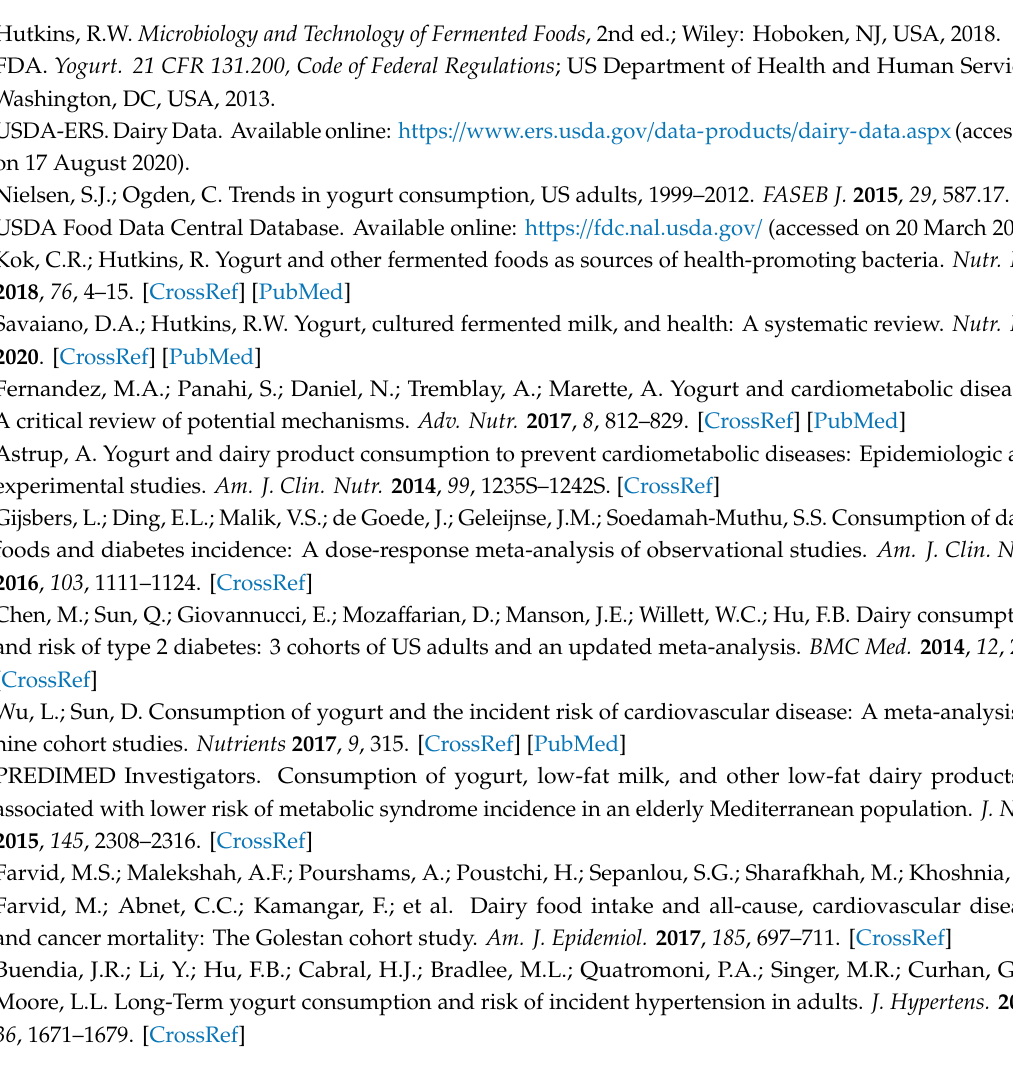
Table S1: Demographics associated with yogurt consumption in children and adults (NHANES 2001-2016, gender combined